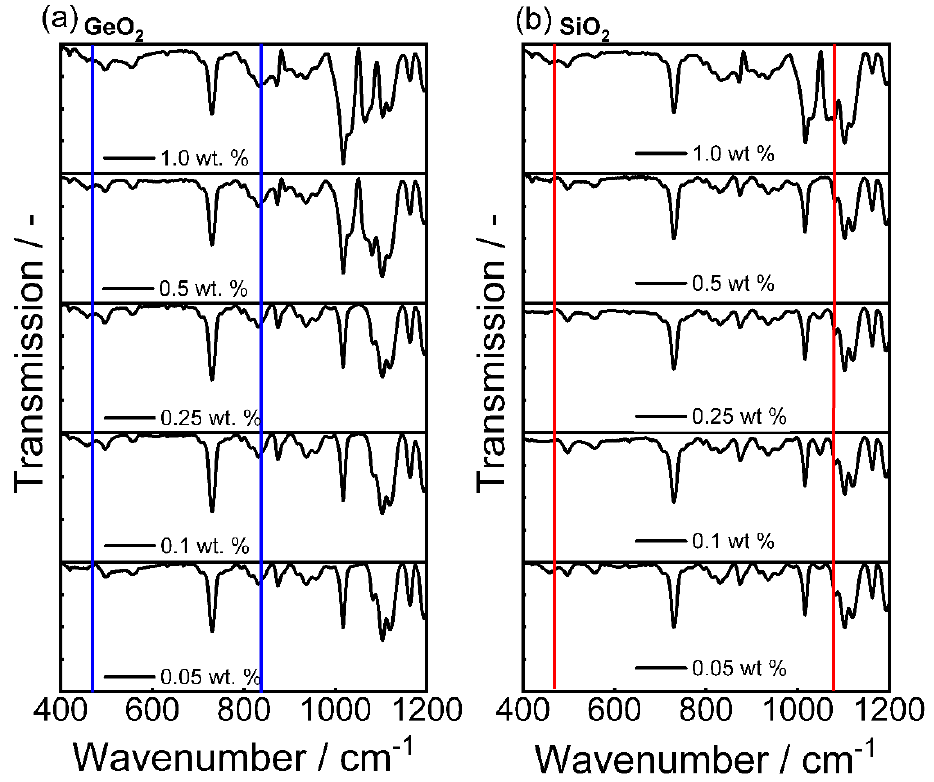
Figure 10. IR spectra of the different PBT ‐ PC ‐ glass blends; ( a ) with pure GeO 2 ; ( b ) with pure SiO 2 . Bands are taken from Table 6.